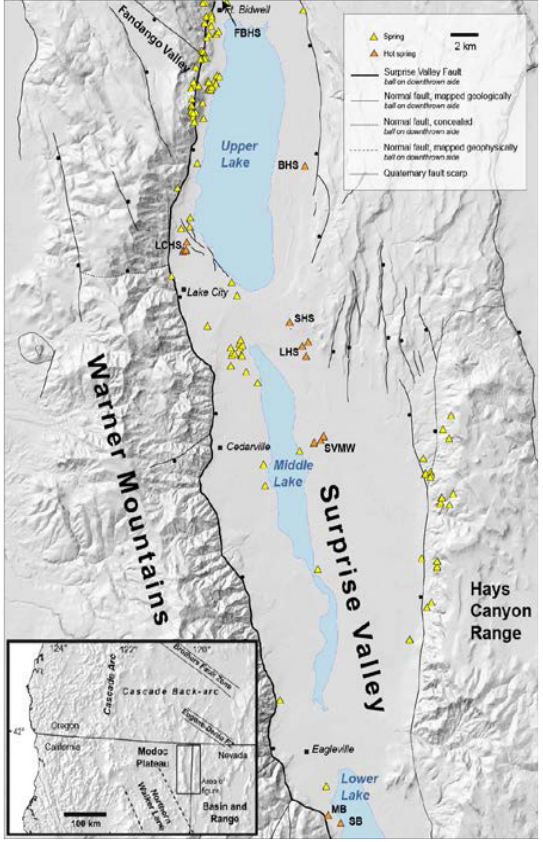
Figure 4. Fault and geothermal features in Surprise Valley, CA [from J. M. G. Glen, U. S. Geological Survey